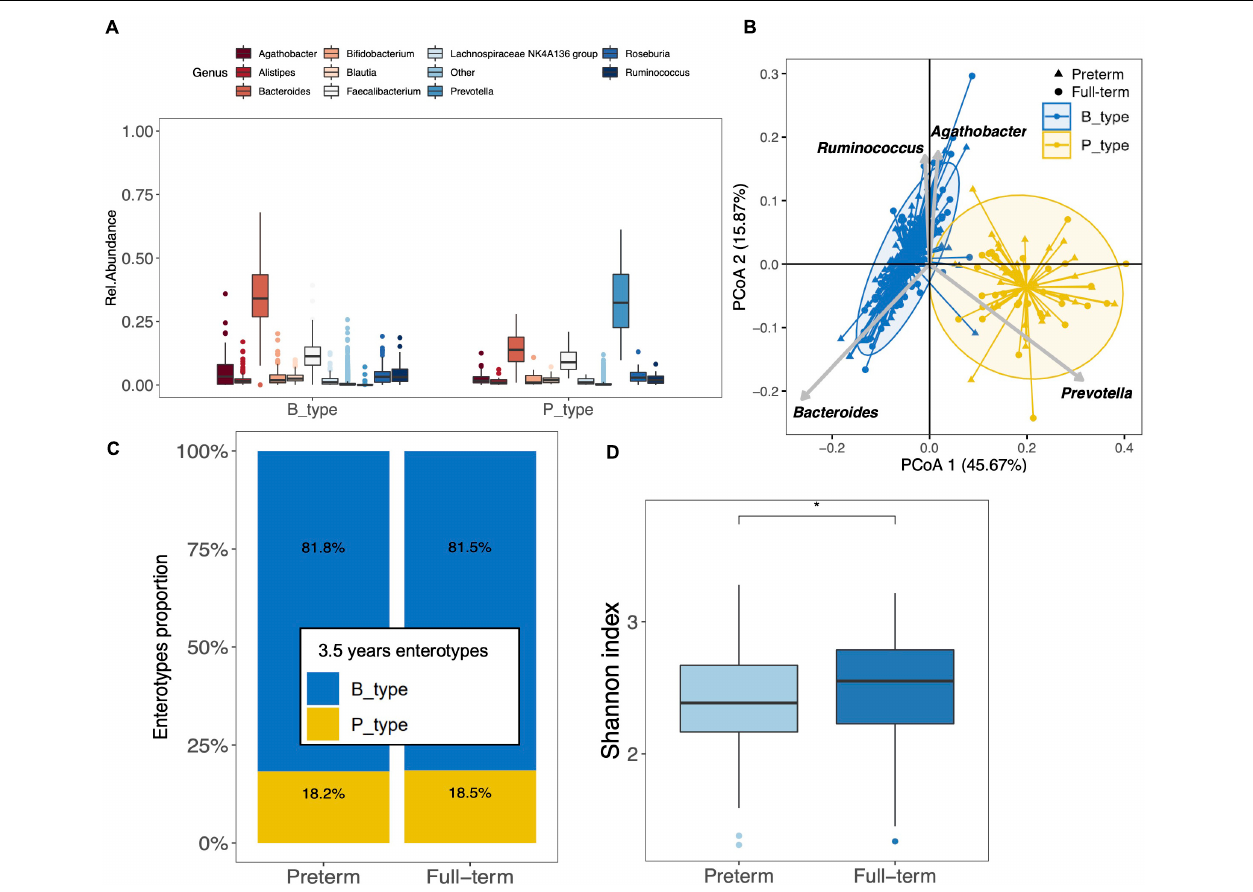
FIGURE 3 | Clustering of the gut microbiota of preterm ( n = 159) and full-term ( n = 200) children at 3.5 years of age. (A) The boxplots represent the relative abundance of the top 10 genera distributed between the B_ and P_types among the full-term children. The boxplots show the smallest and largest values, 25 and 75% quartiles, the median, and outliers. (B) Gut microbiota clustering of the 159 preterm and 200 full-term children at 3.5 years of age based on the genus taxonomic profile. Biplot arrows indicate the top four genera that drive samples to different locations on the plot. (C) Distribution of enterotypes among full-term and preterm children. The distribution is expressed as the proportion of each enterotype among each group of children. (D) Boxplot of alpha diversity assessed by Shannon index based on the genus taxonomic profile between preterm and full-term children (* p < 0.05). The boxplots show the smallest and largest values, 25 and 75% quartiles, the median, and